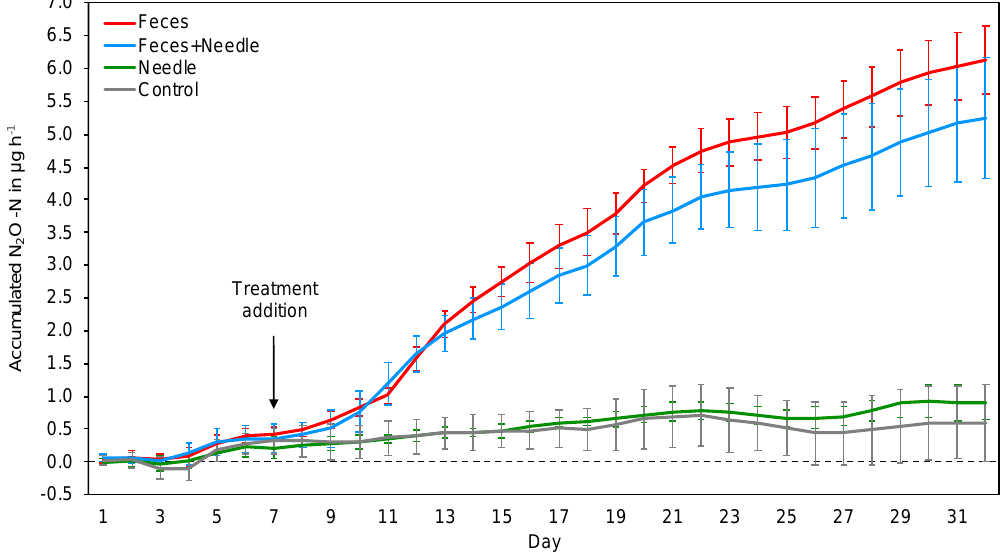
Figure 4. Accumulated N 2 O-N flux ( µ g h − 1 ) of the incubators with treatments of feces from the Pine-tree lappet ( Denrolimus pini L.), feces plus Scots pine ( Pinus Sylvestris L.) needle litter, needle litter, and a control with soil only during the 31 days of the incubation experiment. Treatments were added on day 7 with n = 5. A total of 12 measurements per day were conducted.